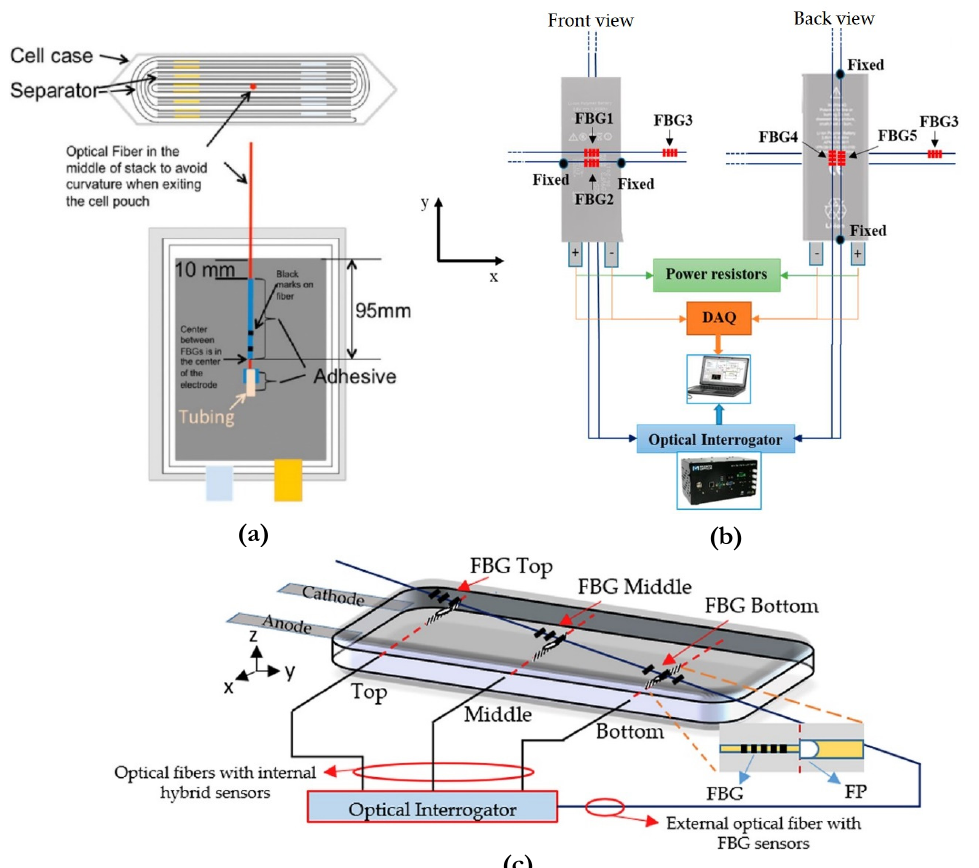
Figure 5. Schematics of various strain-temperature discrimination methods: ( a ) embedded FBGs in an Li-ion pouch cell using the reference sensor method (Reproduced with permission from Raghavan et al., Journal of Power Sources; published by Elsevier, 2017.) [21]; ( b ) experimental setup of externally attached FBGs on an Li-ion pouch cell surface using the reference sensor method [121]; ( c ) externally attached hybrid FBG–Fabry–Perot (FP) sensors on an Li-ion pouch cell surface using a single fiber discrimination method (Reproduced with permission from Nascimento et al. Journal of Power Sources; published by Elsevier, 2019.) [85].